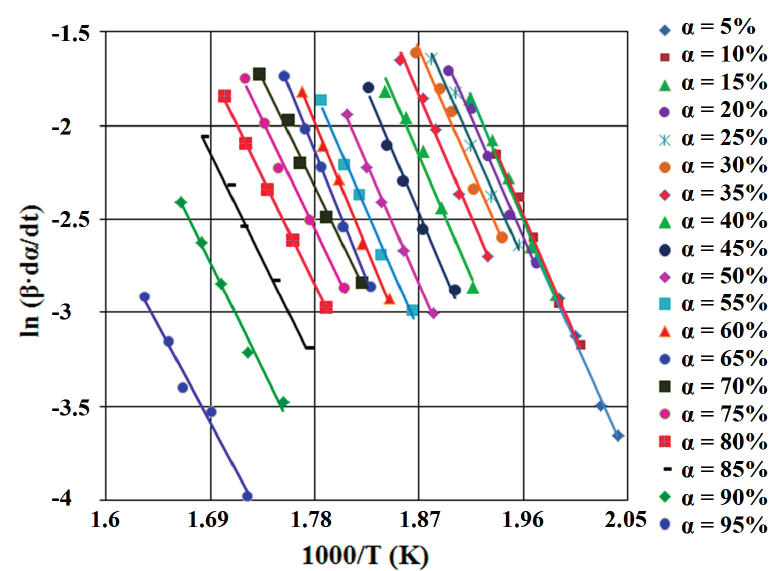
Figure 7. FR diagram, for SB2